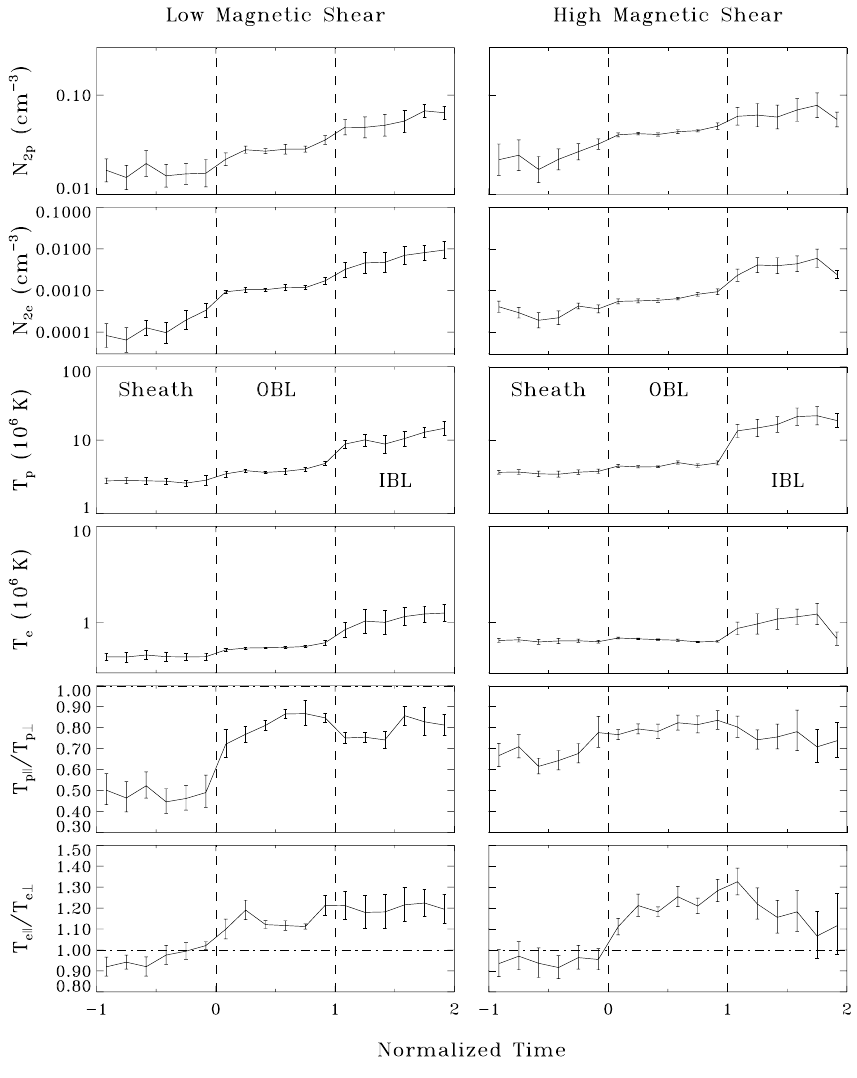
Fig. 3. Superposed epoch analysis of and the partial density, N 2 p , of pro- tons above 8keV, and the partial den- sity, N 2 e , of electrons above 1.8keV, the proton temperature, T p , the electron temperature, T e , the proton tempera- /T p ⊥ , and the elec- ture anisotropy, T p k tron temperature anisotropy, T e k /T e ⊥ , across the outer boundary layer. The format is the same as in Fig.